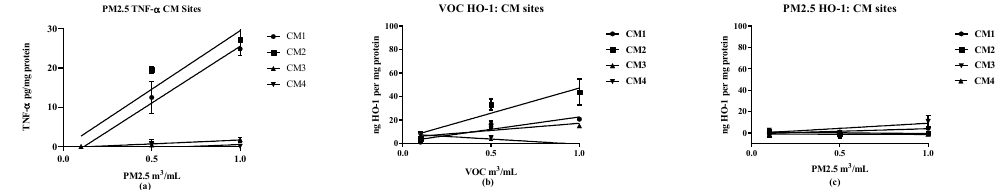
Figure 7. TNF- α expression ( a ) and HO-1 expression ( b , c ) in RAW 264.7 macrophages using air samples collected nearby CM railroads (CM1—closest, CM4 most distant). Macrophages were incubated with three concentrations of VOC or PM for 16 h. The lines represent the best line fit following linear regression analysis of the results (n = 3 for each data point) with potencies indicated by the slopes (values of the regression are detailed in supplemental data—Tables S4 and S5).